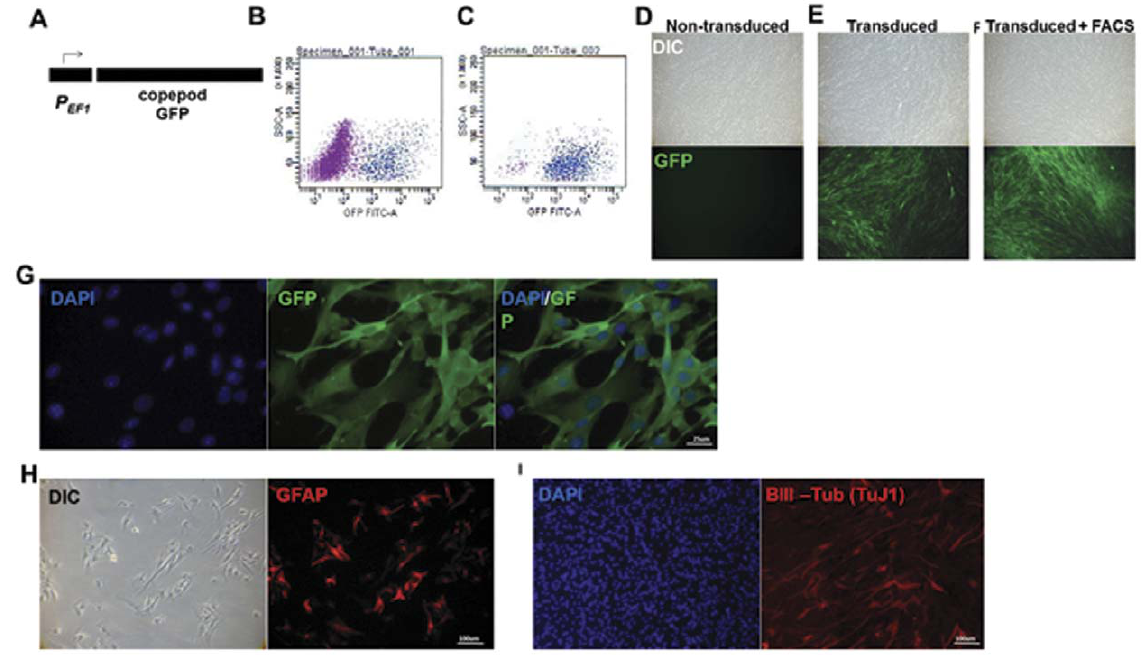
Figure 1. Exvivo manipulation of NSCs. NSCs were transduced with Lentiviruses with GFP driven by the elongation factor 1 promoter (EF1) (A). Transduction involved exposure of NSCs to virus concentrate for 1.5 hours with intermittent agitation. Following transduction, a population of more fluorescent NSCs was observed by FACS analysis (B). Highly fluorescent cells defined by AU . 10 3 (C) formed cultures with more uniform and robust expression of GFP (D–G). Enriched NSCs formed expandable, long-term monolayers which expressed GFAP and BIII-Tubulin, markers commonly associated with multipotent astrocytic stem cells (H–I). GFP fluorescence was detected directly in B–F and indirectly with an antibody specific to GFP in G. The data are representative examples from three repeated isolations and transductions of